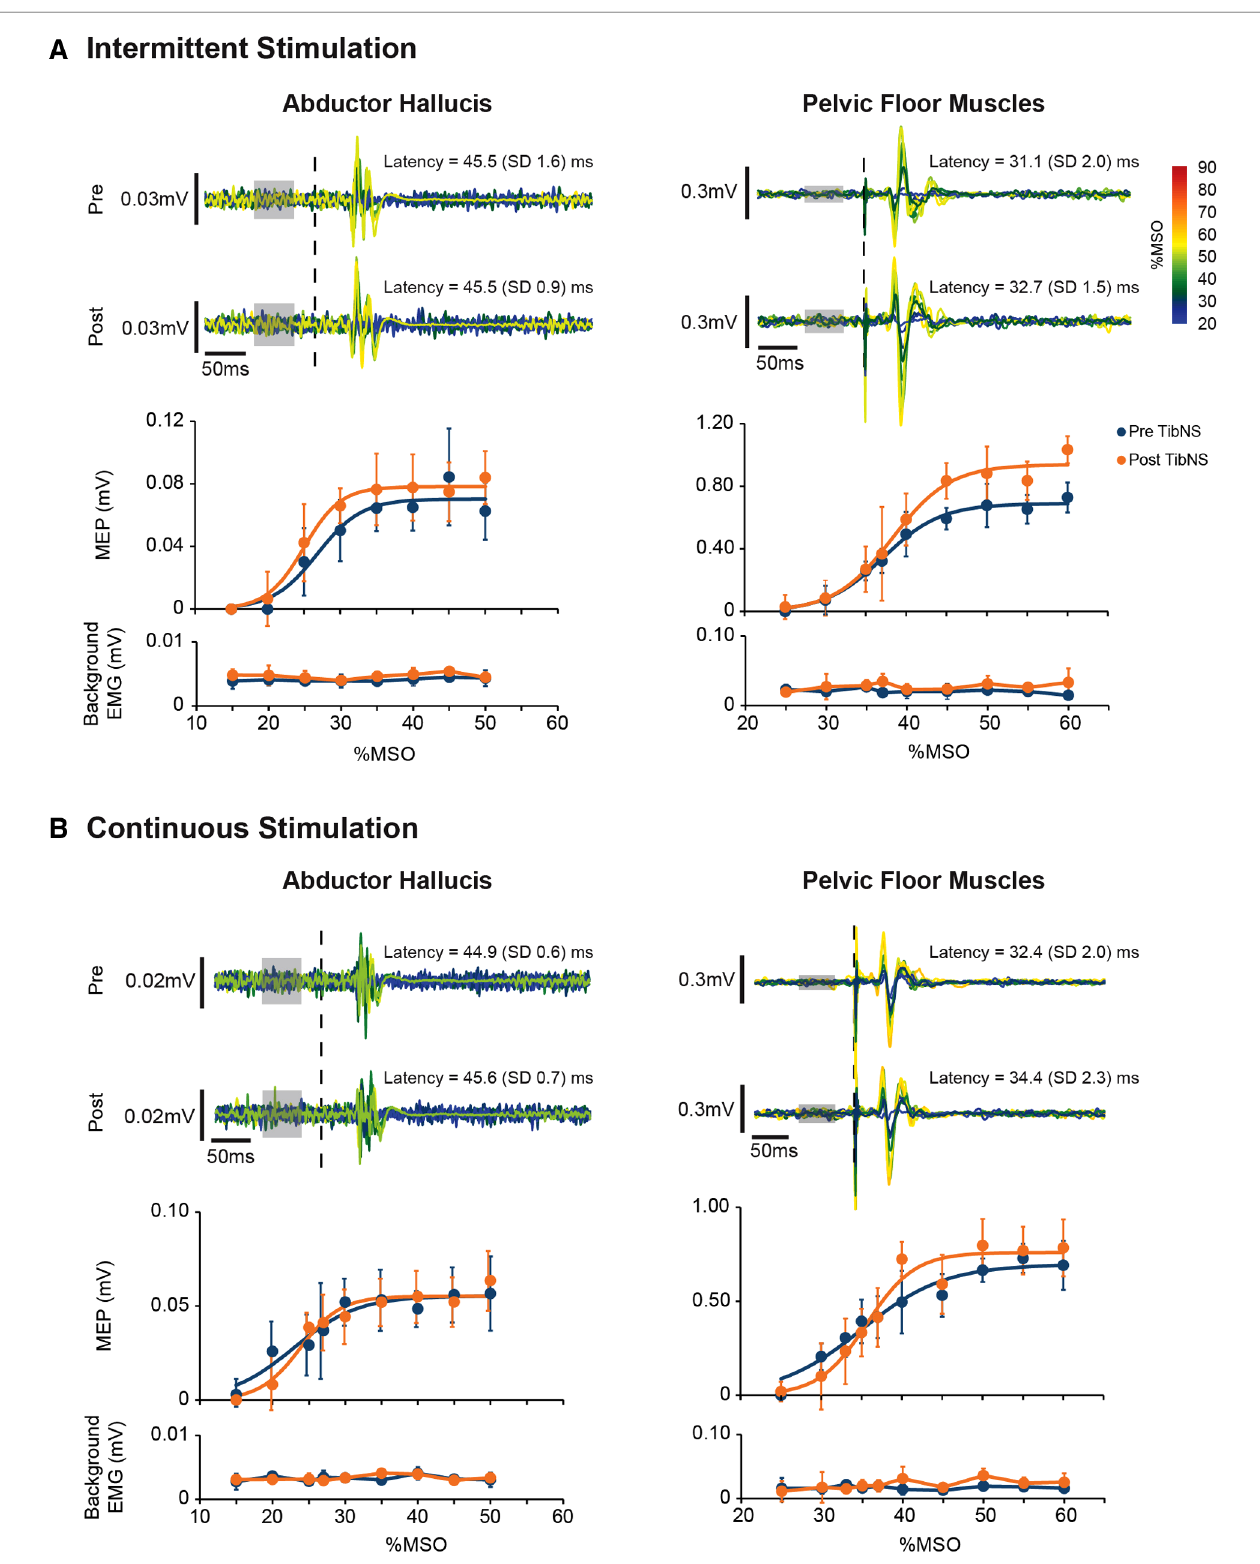
FIGURE 4 Motor-evoked potentials (MEP) in the abductor hallucis and pelvic fl oor muscles from an exemplary participant pre and post intermittent ( A ) and continuous ( B ) TibNS. Top panels represent superimposed raw MEP responses to incrementing TMS intensities. The intensity of TMS stimuli [% maximum stimulator output (MSO)] are rainbow color-coded. The time of TMS pulse delivery is indicated by the dotted line. Background EMG used to calculate MEP threshold is indicated by the gray boxes. Bottom panels represent the MEP SR curves pre-and post-TibNS. The mean MEP response at each TMS intensity at pre- and post-TibNS (blue and orange dots, respectively), are plotted with error bars representing standard deviations. Solid lines represent the fi tted Boltzmann sigmoidal function. Background EMG is also plotted underneath the SR curves with error bars representing standard deviation to show consistency of background EMG activity between pre- and post-TibNS as well as across different TMS